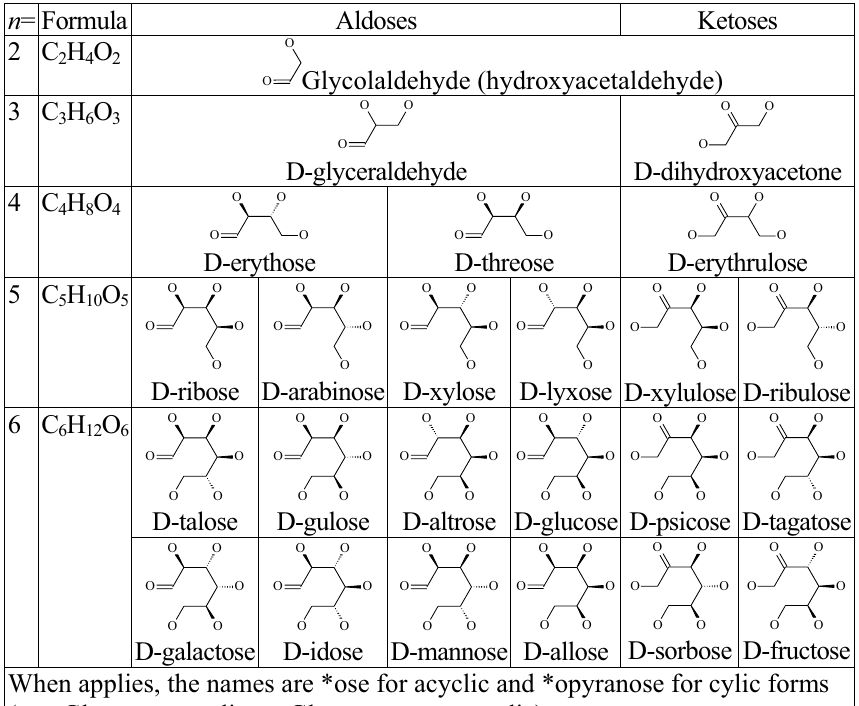
Table 1 Monosaccharides from diose to hexoses in open-chain (acyclic) form